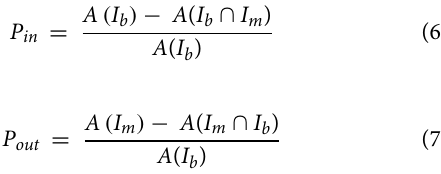
deformation; (C) Surface wave observations (blue) and model fit (red); (D) body wave observations (blue) and model fit (red). Surface deformation for the Padang consensus source mode (E) .